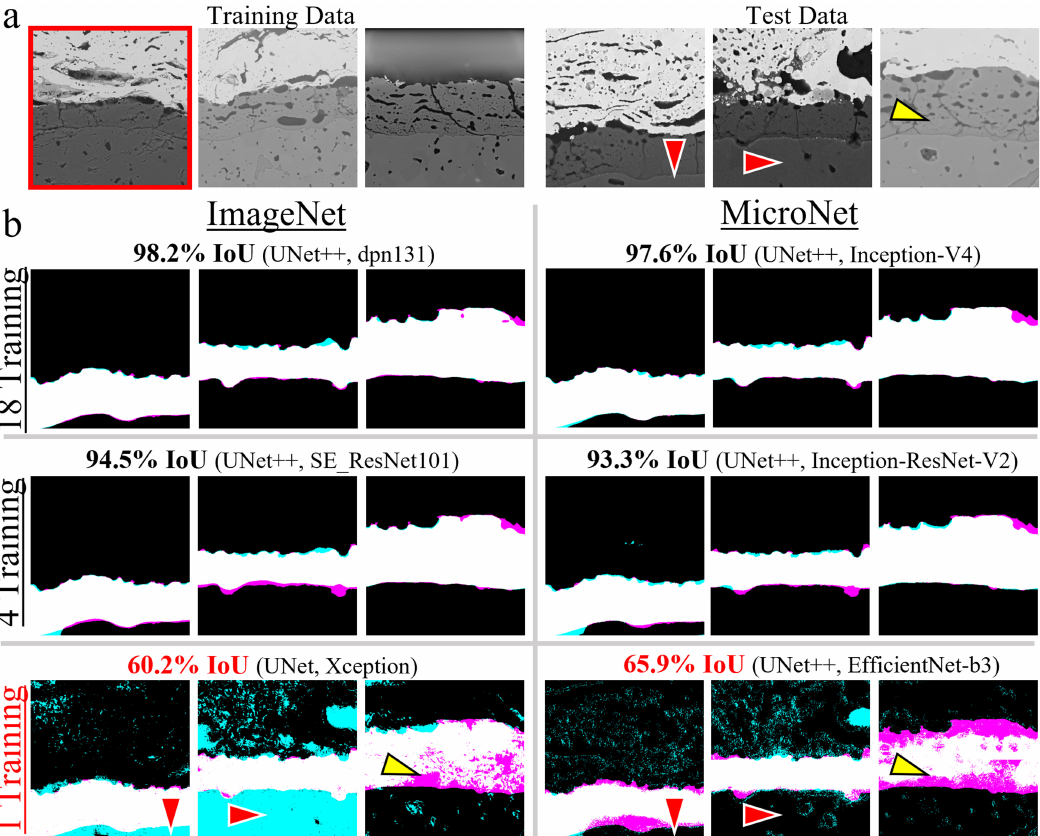
Fig. 5 Results of EBC segmentation. a shows examples from the train and test splits of the EBC datasets. The single training image for EBC-3 outlined in red. b shows the segmentation results for the top ImageNet and MicroNet models for each EBC experiment. The accuracy mask colors represent the same as in Fig. 3. The red triangles indicate example locations on the test image where the ImageNet models were not able to distinguish between the substrate and the thermally grown oxide when training on a single image. The yellow arrows indicate locations where the thermally grown oxide was under segmented when training on a single image with both the MicroNet and ImageNet models.